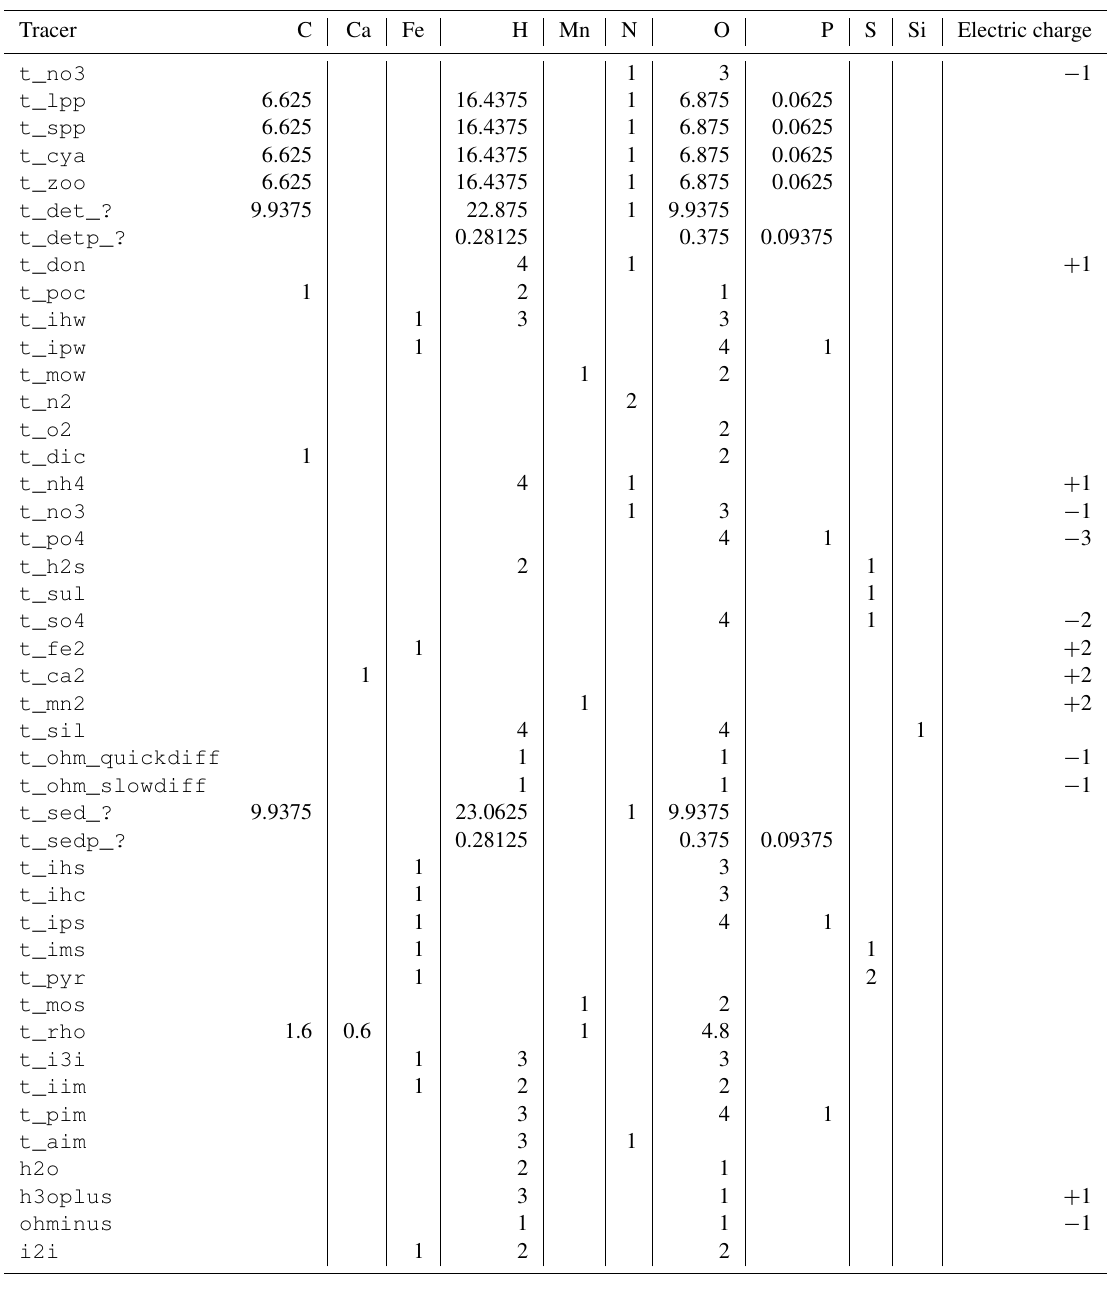
Table A1. Stoichiometric composition of tracers.